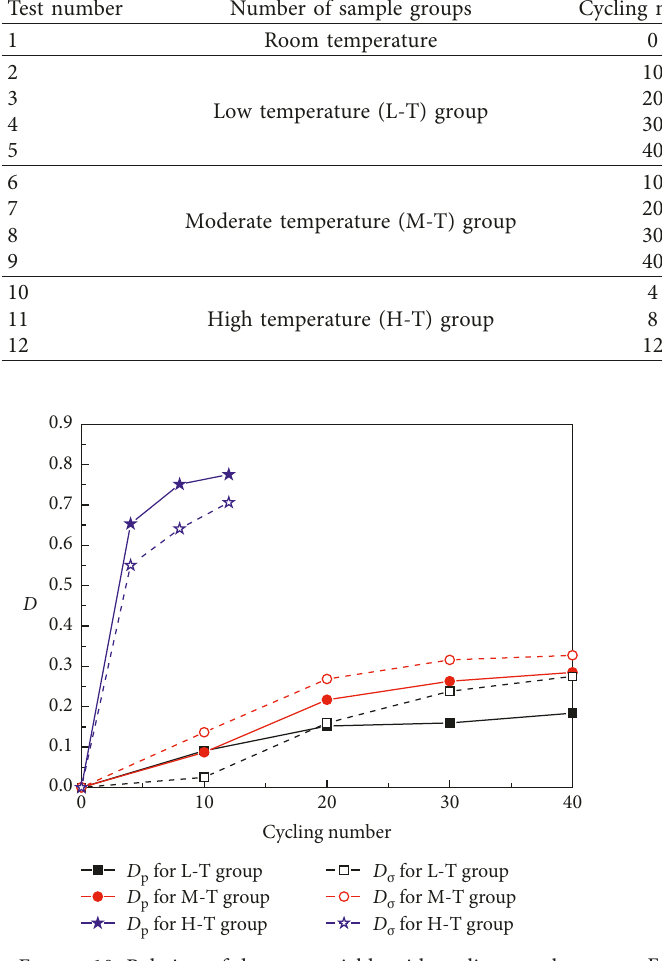
Figure 10: Relation of damage variable with cycling number. Figure 11: Relation of release rate of damage strain energy with cycling